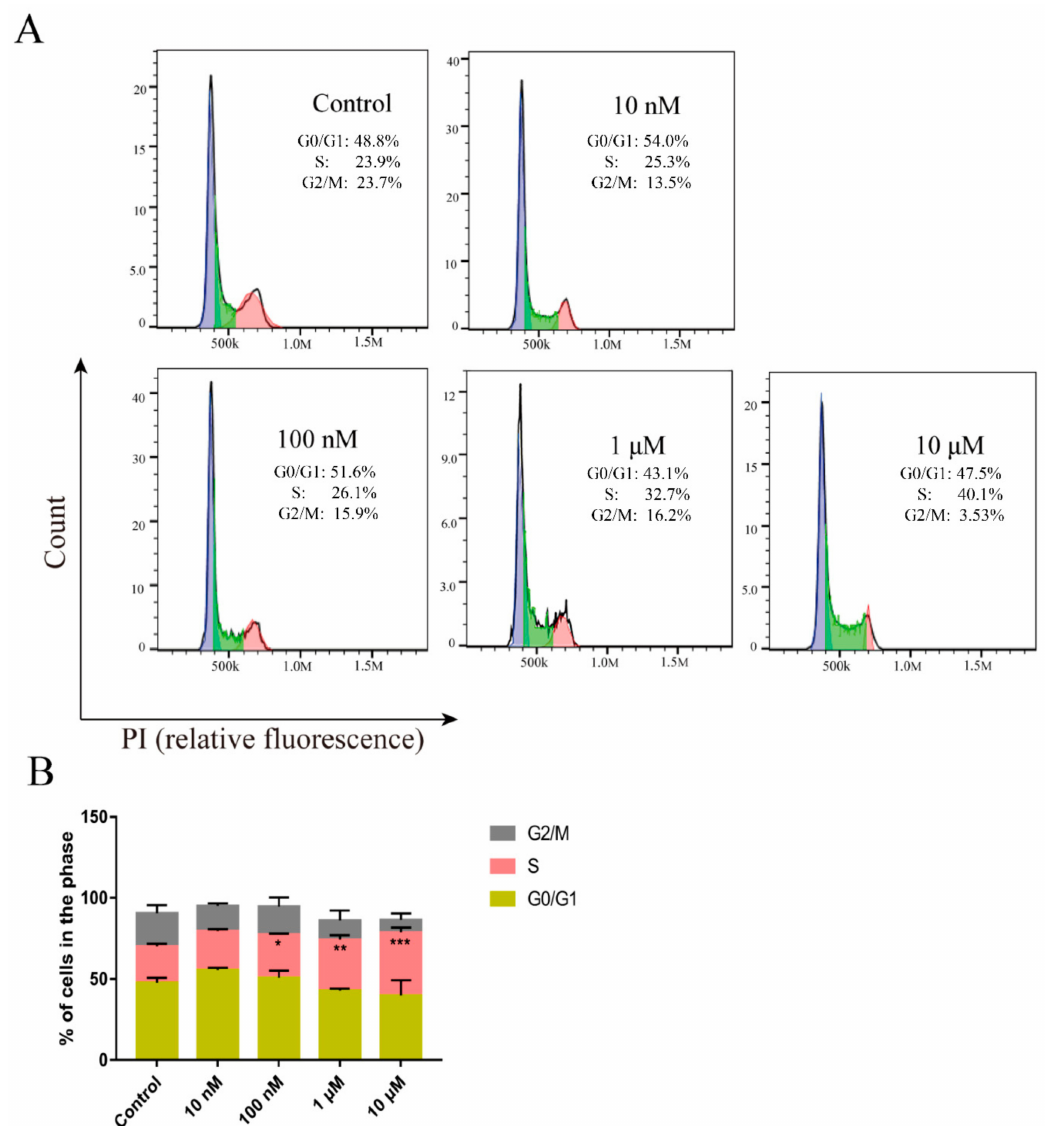
Figure 6. E ff ects of peptide CM 7 on cell cycle against MKN-45 cells. ( A ) MKN-45 cells were treated with the indicated concentrations of CM 7 (0, 0.01, 0.1, 1, and 10 µ M) for 48 h; then, the cell cycle distribution was analyzed by flow cytometry. ( B ) Representative histograms for cell cycle distribution in MKN-45. Results are presented as mean ± SD (n = 3). * p < 0.05, ** p < 0.01, *** p < 0.001 vs control, one-way ANOVA with multiple